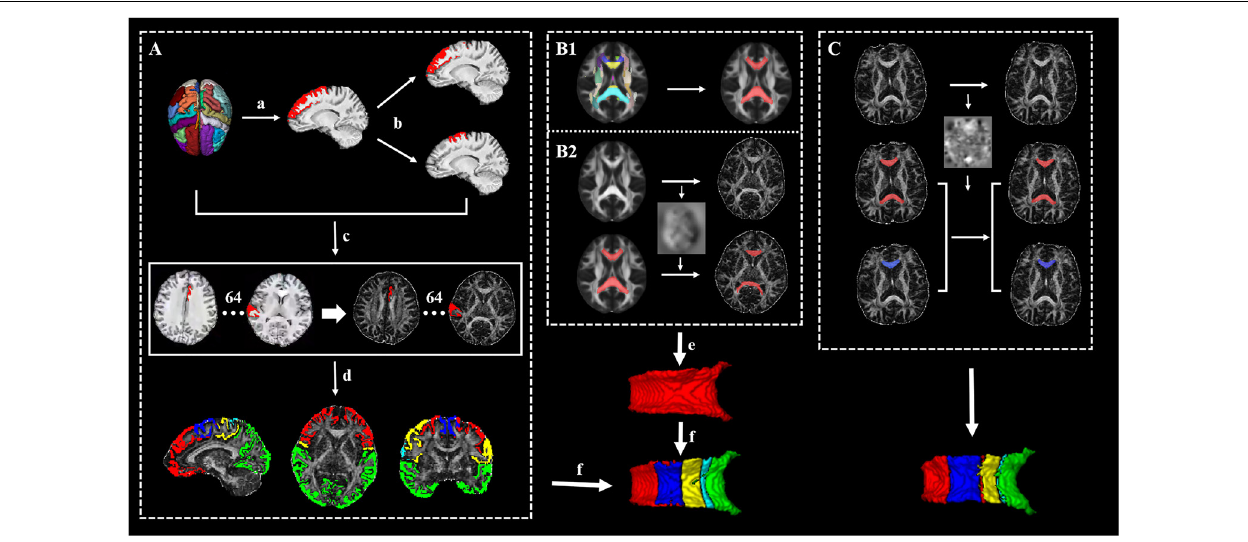
FIGURE 1 | The framework of the whole processing steps. (A) The generation of targets: (a) The cortex was segmented to 62 segmentations by using the Desikan–Killiany–Tourville (DKT) cortical labeling protocol, then thresholded with 0.5, and binarized. (b) The premotor gyrus and prefrontal gyrus were separated from the superior frontal gyrus. (c) A total of 64 cortical segmentations were acquired and transformed to the diffusion space. (d) A total 64 cortical segmentations were merged to five distinct segments. (B1) The acquisition of standard callosal mask. (B2) The semi-automatic procedure of seed delineation. (e) Manual adjustment of seed. (f) Connectivity-based parcellation. (C) The segmentation scheme of corpus callosum (CC) in follow-up data for acquiring follow-up whole CC (red) and its subsections (blue, just listed callosal prefrontal subsection as an example).